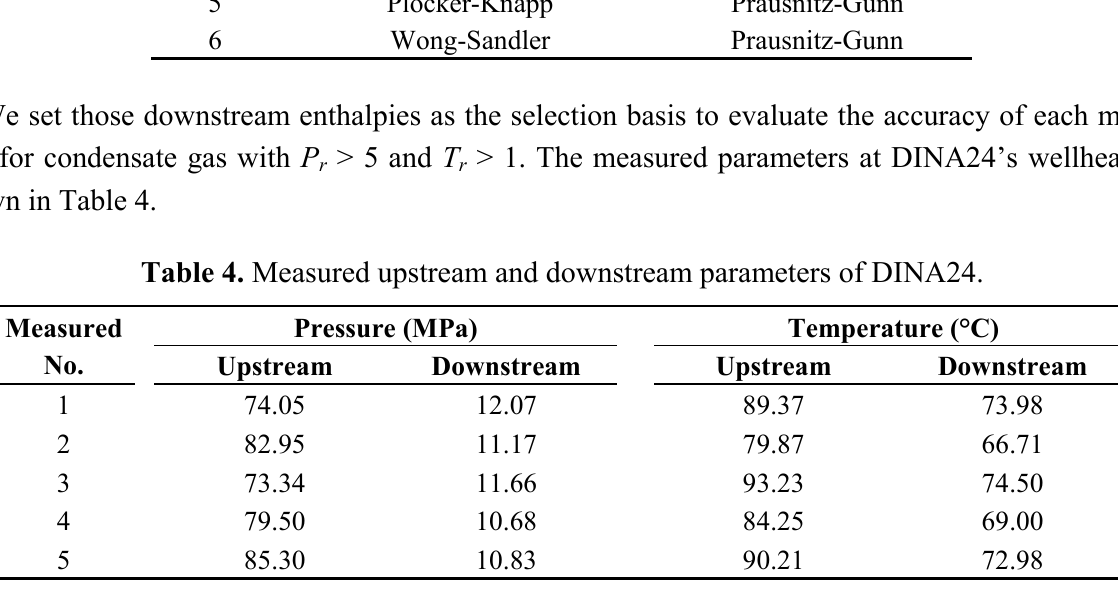
Table 3. Mixing rules for P